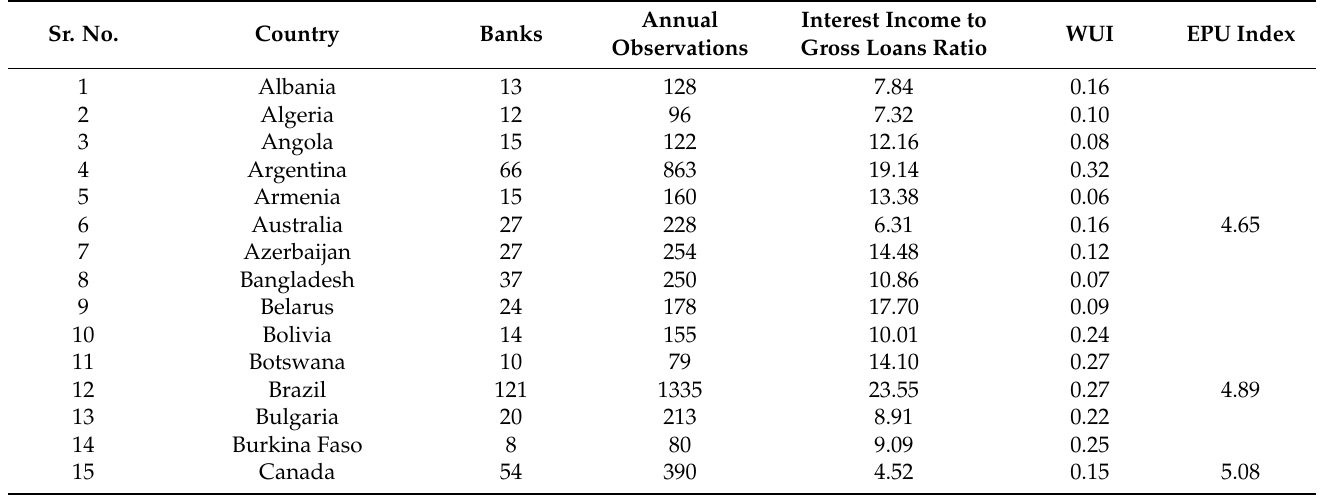
Table 1. Sample distribution. This table reports sample distribution and country-level mean values of dependent and main independent variables. WUI is world uncertainty index of Ahir et al. (2018). EPU index is news-based economic policy uncertainty index of Baker et al.